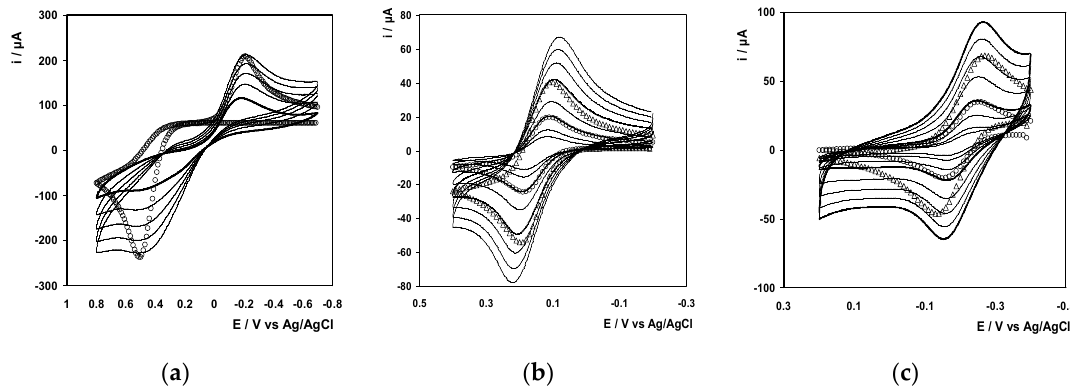
Figure 10. Cyclic voltammetry of 1 mM ( a ) ferri/ferro cyanide, ( b ) ferrocene methanol, and ( c ) ruthenium hexamine, in 0.1 M LiClO4 at a gold-coated silicon wafer electrode functionalized with a rat tail collagen film deposited using a wet chemical method. Scan rates varied from 500 to 10 mV/s. The open circles are the best fits to a semi-infinite linear diffusion-controlled model in which the adjustable variables are the standard heterogeneous electron transfer rate constant, k o’ , and the fractional area (values in Table 2).